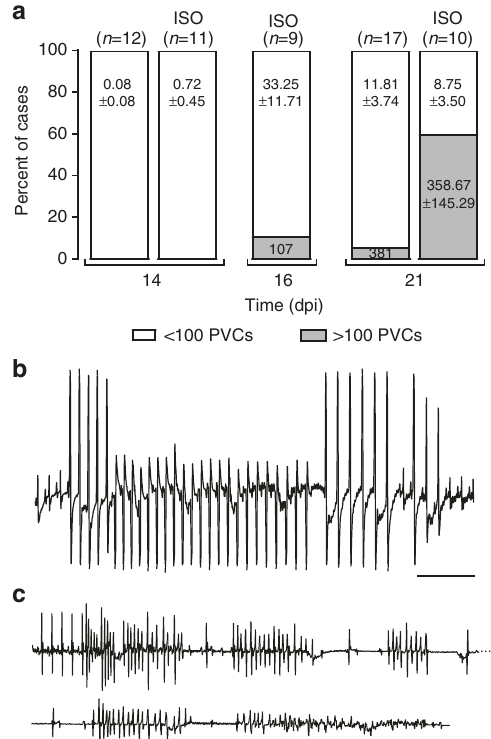
Fig. 2 Isoproterenol-induced arrhythmias in PKP2-cKO hearts. a Incidence of spontaneous, and of isoproterenol-induced (ISO) PVCs during 20 min of recording in anesthetized PKP2-cKO mice as a function of days post- tamoxifen injection (dpi). Data reported as percent of total animals studied per time point and condition; number of animals in parenthesis at top of each bar. Numbers inside bars indicate mean ± SEM of ventricular extrasystoles. b Example of ISO-induced non-sustained ventricular of ISO-induced fatal ventricular tachycardia/ fi brillation (VT/VF) in a